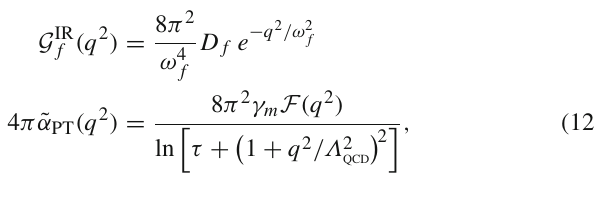
Table 1 Model parameters (in GeV): m m f ( 2GeV ) , ω f and κ f = (ω f D f ) 1 / 3 . M E